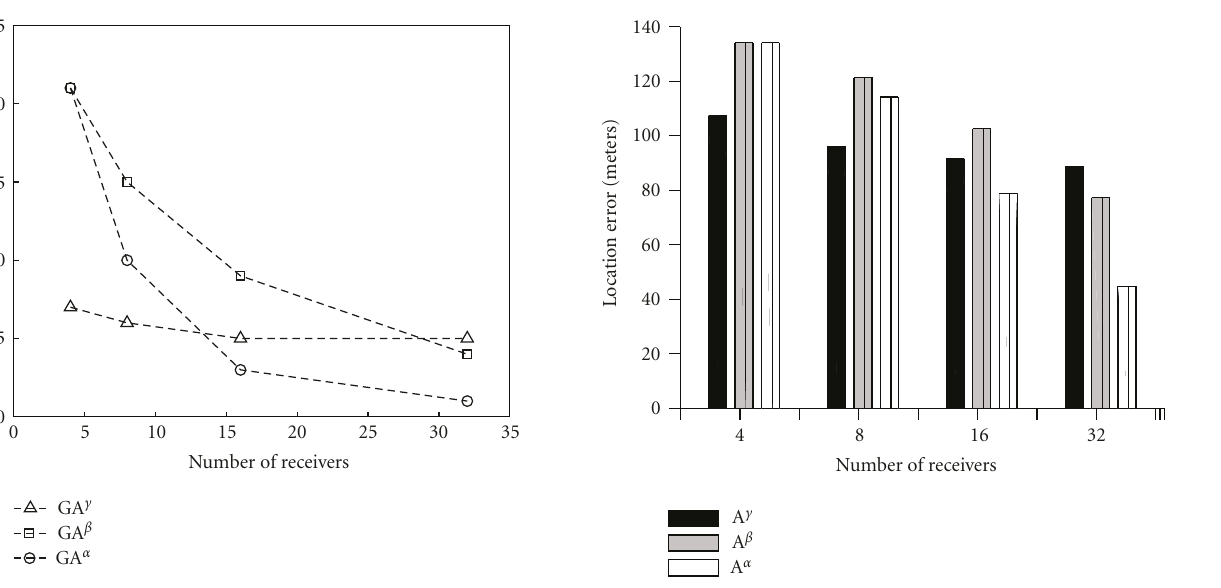
Figure 6: Grid candidate area size for C = 0 . 95.